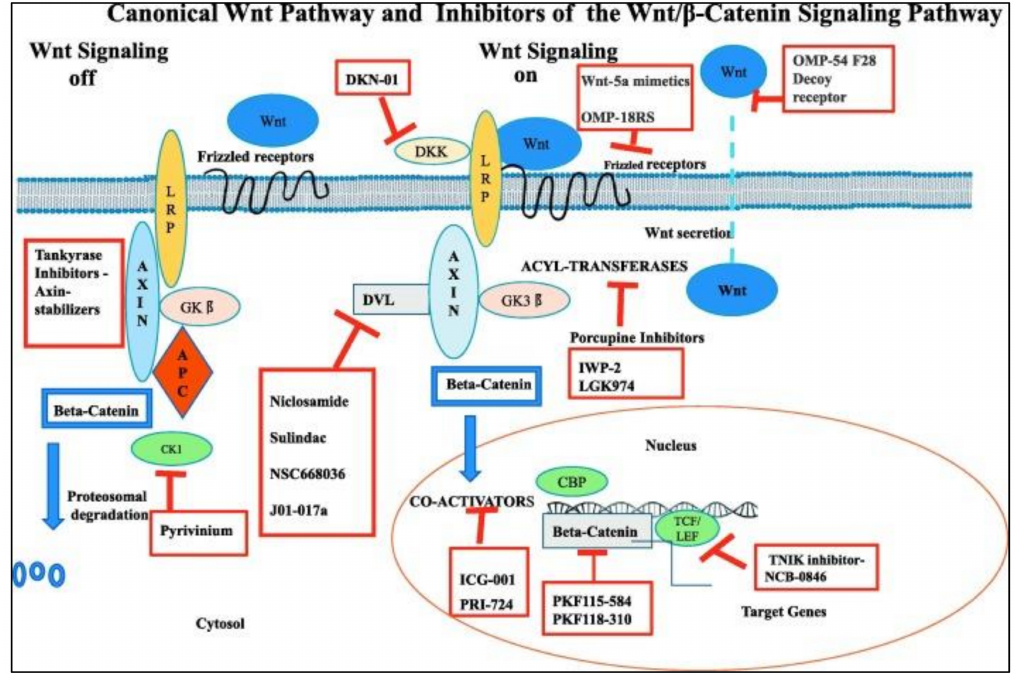
Figure 2. Canonical Wnt Pathway and Inhibitors of the Wnt / beta-Catenin Signaling Pathway schematic representation of the Canonical Wnt Pathway and pharmacologic inhibitors of the Wnt / beta-catenin signaling pathway. Reproduced with permission from Krishnamurthy N, Kurzrock R. Targeting the Wnt / beta-catenin Pathway in Cancer: Update on E ff ectors and Inhibitors. Cancer Treatment Reviews. 2018, 62, 50–60